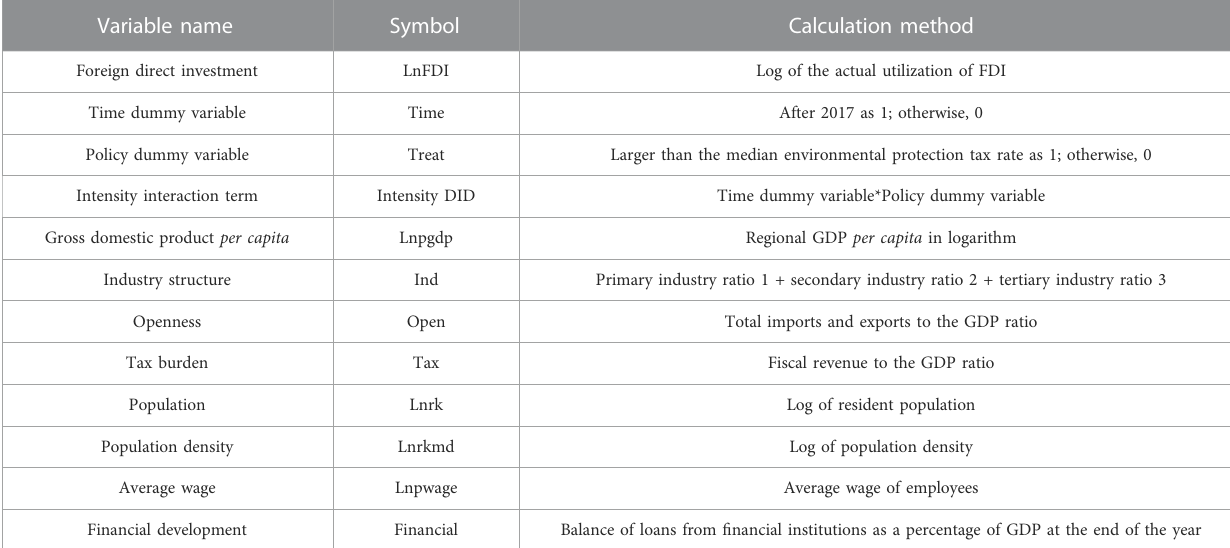
TABLE 1 Variable names, symbols, and calculation methods.